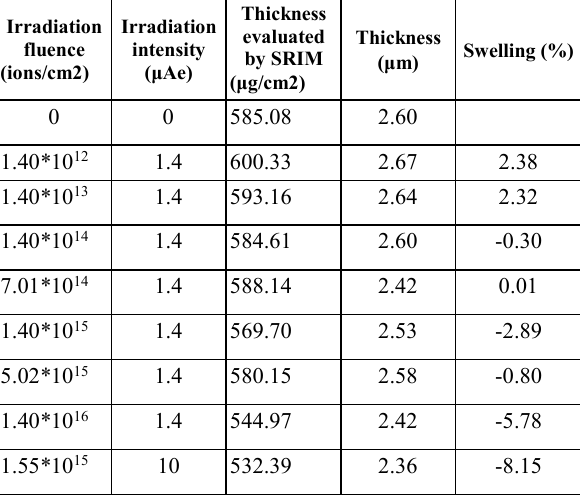
Table 3. Analysis of the measurements of DLC